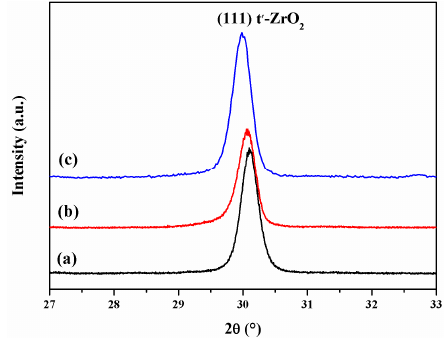
Figure 9. XRD patterns of ( a ) plasma-sprayed, ( b ) dotted, and ( c ) DA coatings before the hot corrosion test at the 2 θ range of 27°–33°.